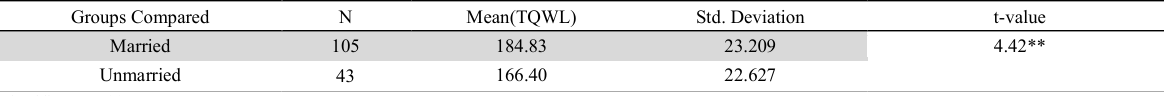
Mean, SD’s and t-value of married and unmarried sector of employees on total QWL Groups Compared N Mean(TQWL) Std. Deviation t-value Married 105 184.83 23.209 4.42** Unmarried 43 166.40 22.627